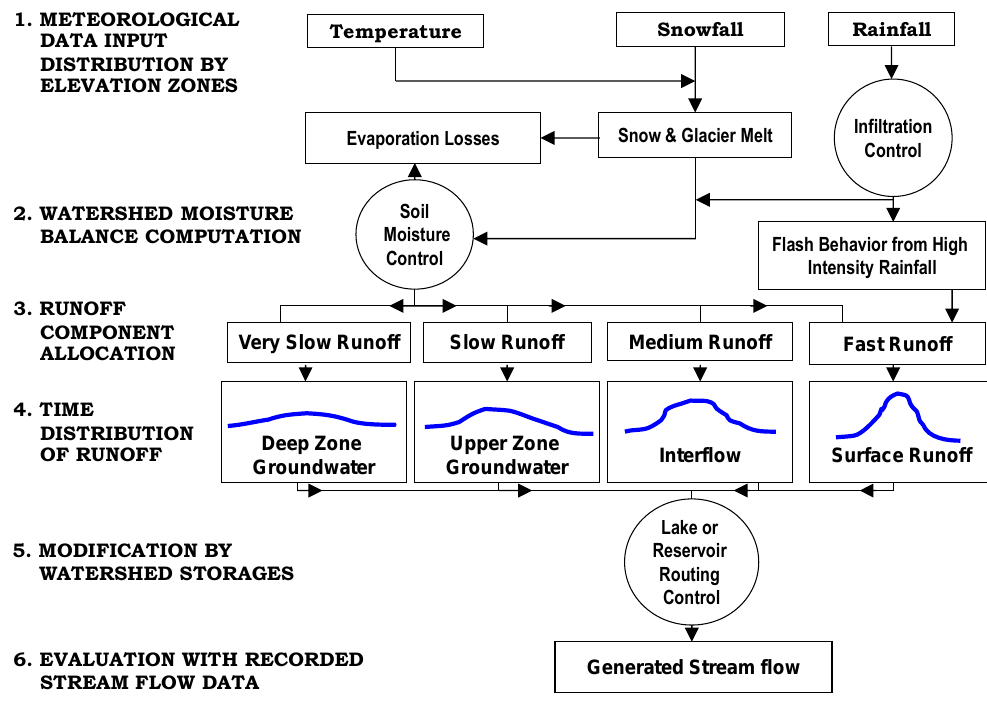
Figure 2. The schematic diagram of the UBC watershed